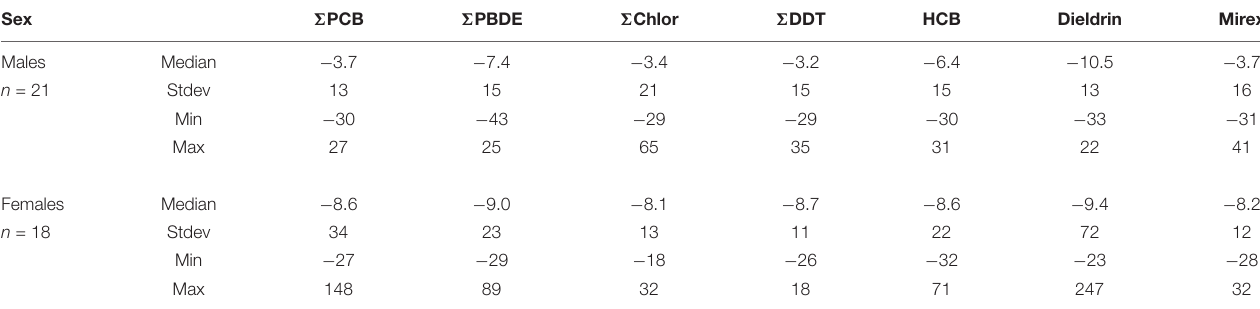
TABLE 4 | Percent declines per year in POPs based on